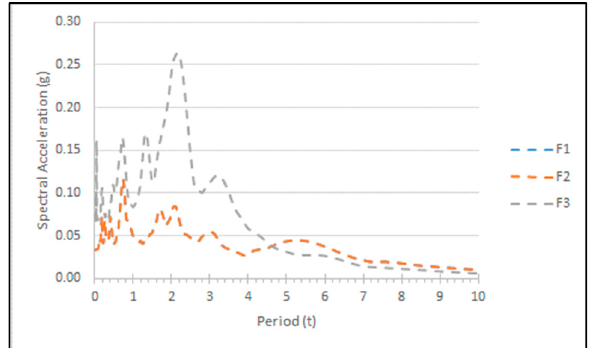
Figure 6. Sample of the spectral acceleration for D4 under far-field seismic events.